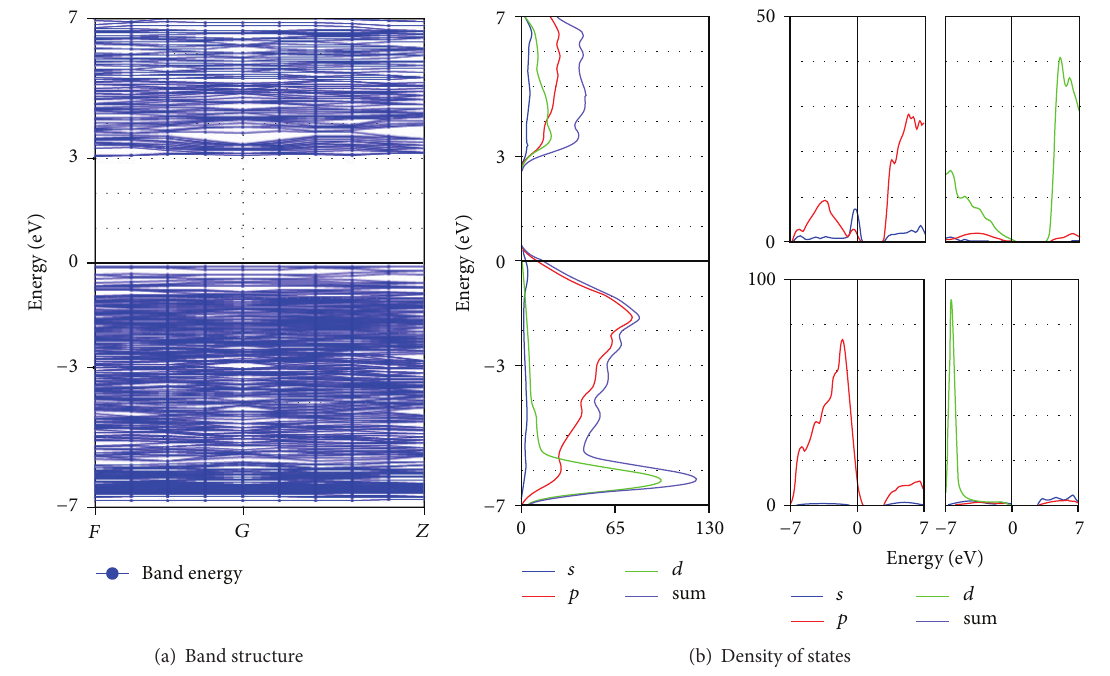
Figure 10: The band structure and DOS for the BZT ordered solid solution